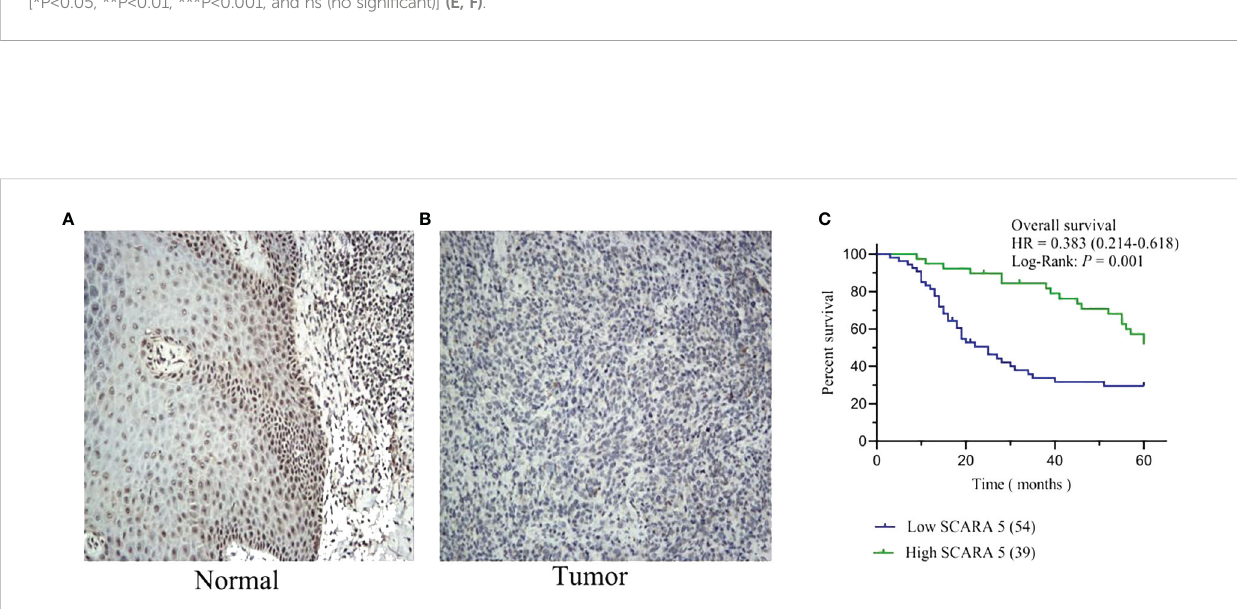
FIGURE 10 Expression of scavenger receptor class A member 5 ( SCARA5 ) in SKCM and survival analysis of our cases. High SCARA5 expression (IRS 4 – 12) (A) and low expression (IRS 0 – 3) (B) . Through Kaplan – Meier curve assessment, patients with low SCARA5 expression were shown to have a signi fi cantly lower 5-year survival rate than those with high SCARA5 expression ( (C) p = 0.001, log-rank